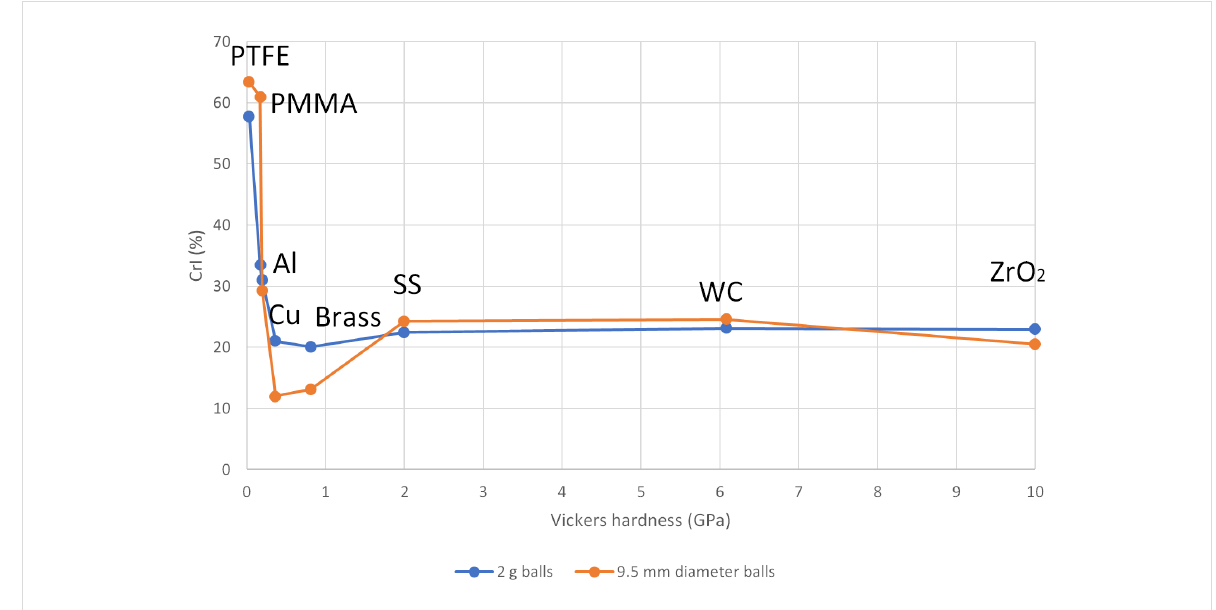
Figure 2: Value of CrI after milling as a function of the Vickers hardness values of the media (Jar and ball) used in this study. Two series are com- pared: One where the balls are 2 g, and one where they are 9.5 mm in diameter. Experimental conditions: 200 mg of chitin, milling time: 30 min, milling frequency 29.5